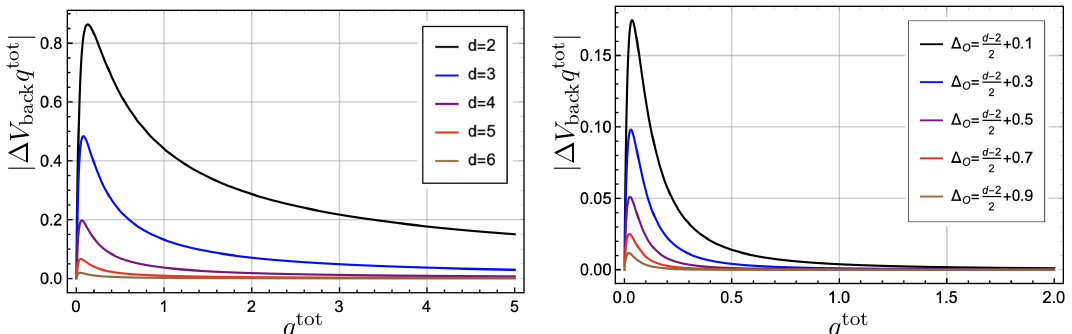
Figure 9. Bound on information transfer as a function of the total momentum of the signal. On the left panel, we find that the bound on information transfer with backreaction decreases as we increase d . Here, we set ∆ O = d − 2 + 0 . 5 . On the right panel, we show the dependency on the 2 conformal dimension when the d is fixed. As an example, we draw the d = 3 case, but other values of d lead to the same qualitative